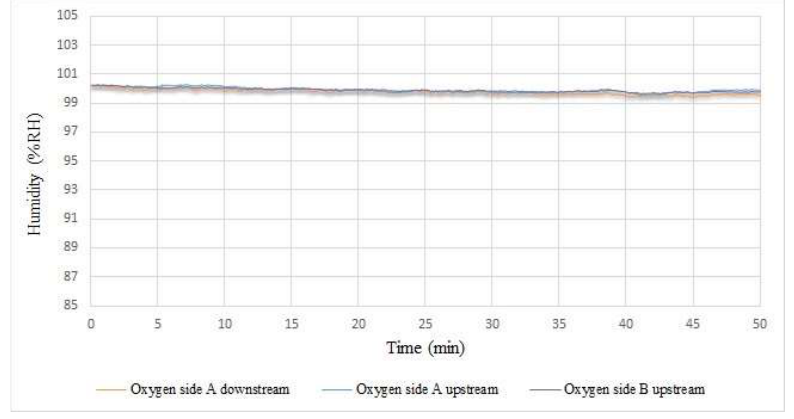
Figure 15. Internal humidity measurement during proton battery stack charging.